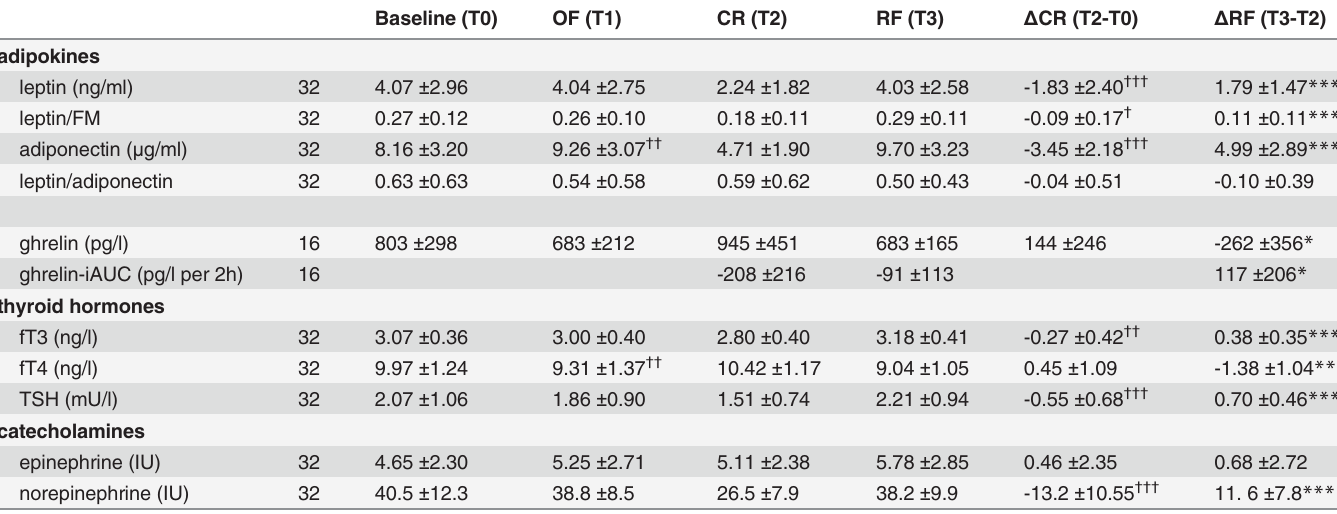
Table 3. Changes in endocrine parameters due to overfeeding (OF) caloric restriction (CR) and refeeding (RF) (values are means ±